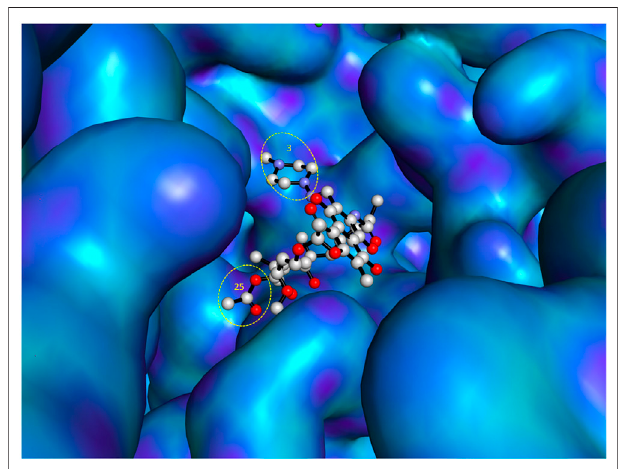
FIGURE 3 | Most accessible positions for conjugation in the chemical structure ofrifampin. The fi gure wasgenerated from the crystal structure (Pdb 5UAL) (Molodtsov et al., 2017) using PyMOL (Delano,